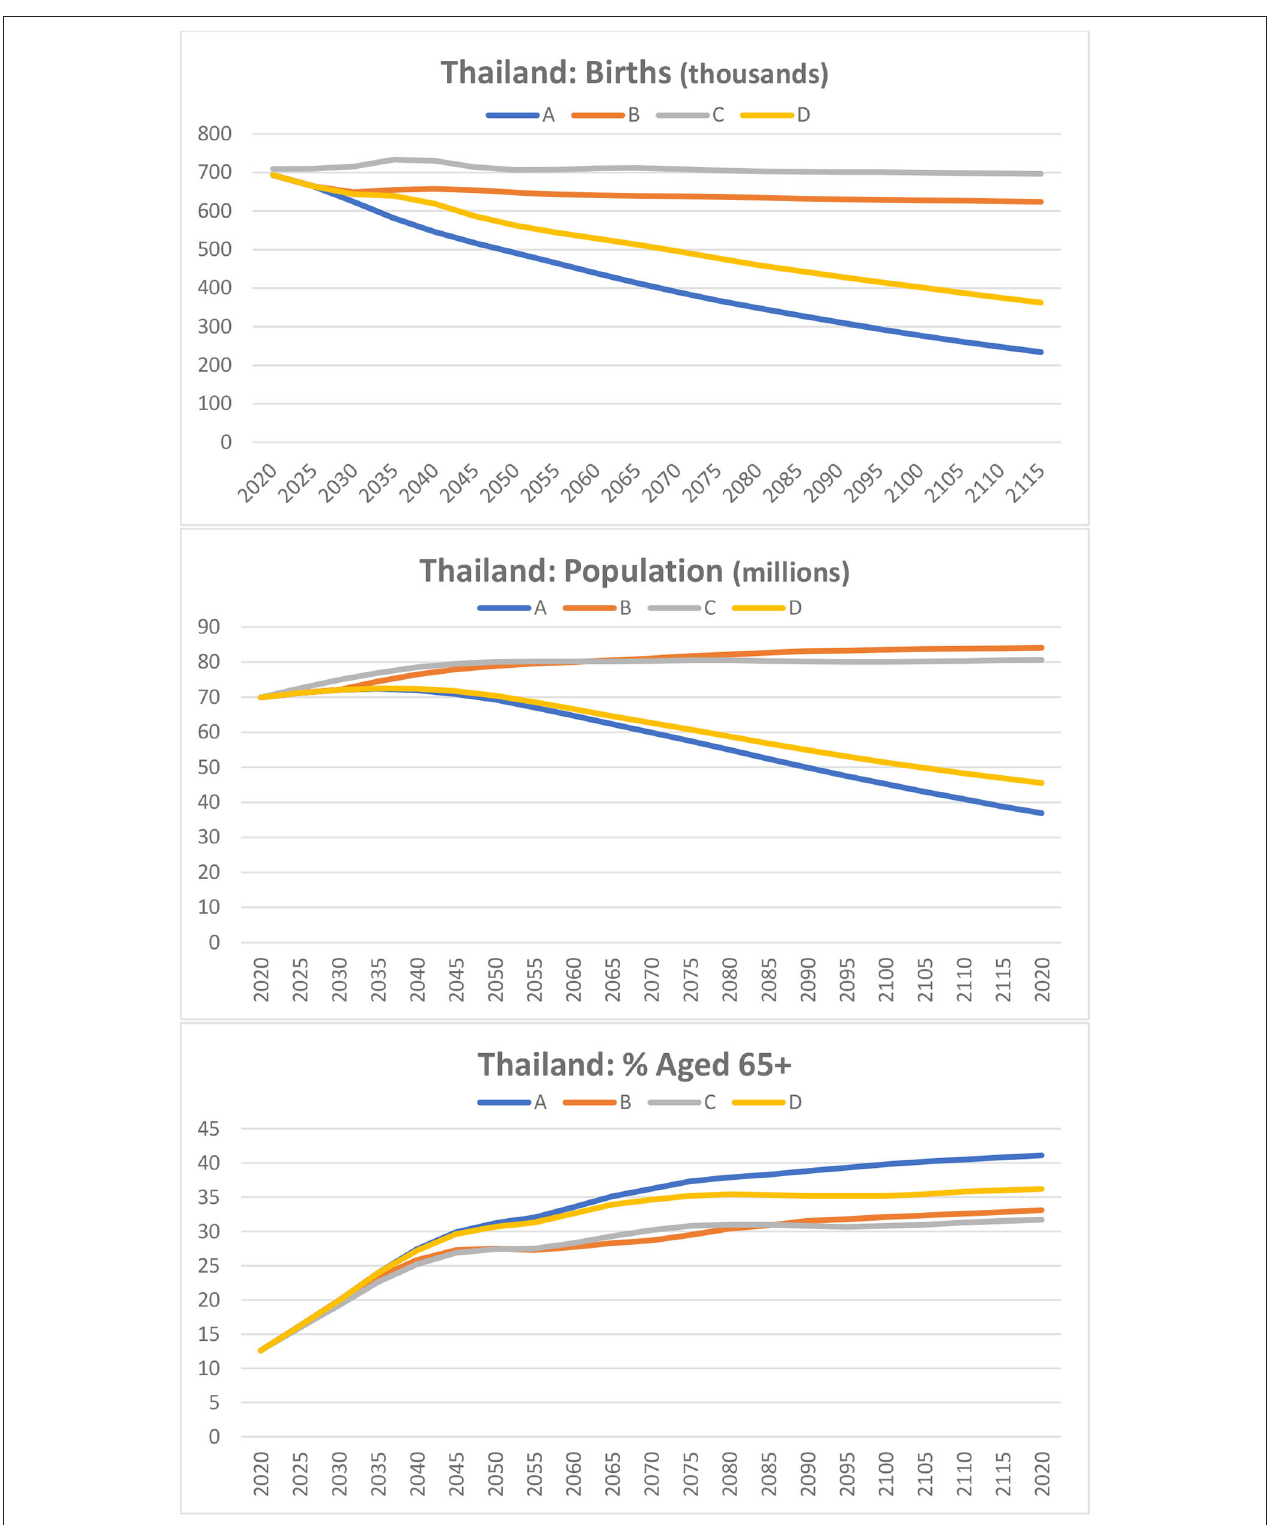
FIGURE 6 | Thailand: Projections of births, population and percent of population aged 65 + . A: TFR = 1.5; Net migration = 0. B: TFR = 1.5; Net migration = 400,000 from 2030. C: TFR rises to 1.7 by 2040; Net migration = 250,000 from 2020. D: TFR rises to 1.7 by 2040; Net Migration = 0.